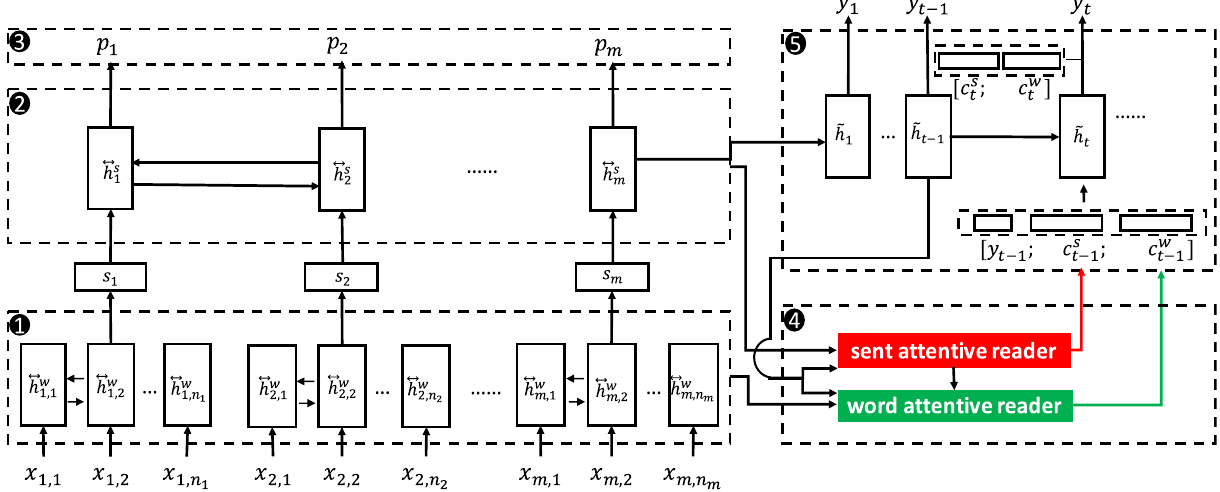
Fig. 1 General framework of our proposed model with 5 components: (1) Word-level encoder encodes the sentences independently word- by-word, (2) Sentence-level encoder encodes the document sentence- by-sentence, (3) Sentence extractor does binary classification for each